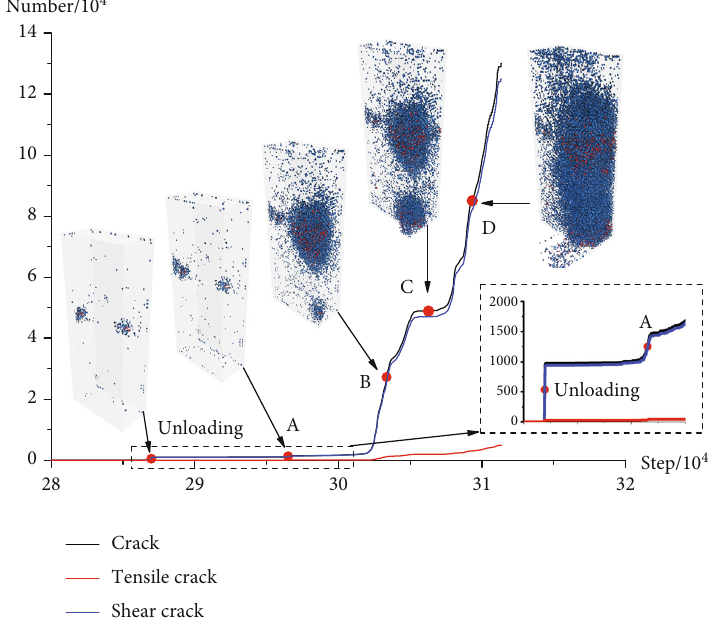
Figure 10: Crack time space evolution process.